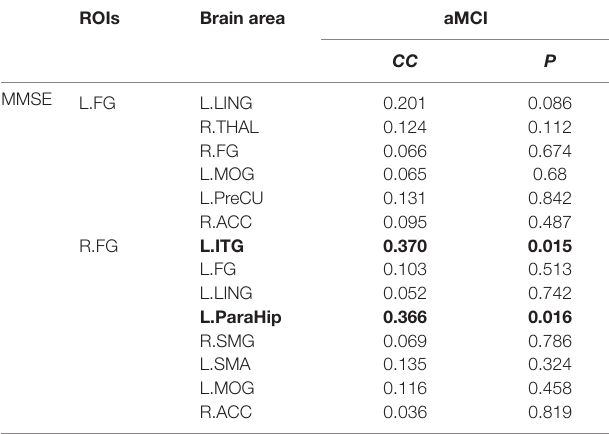
TaBle 4 | This table shows the correlation coefficient and corresponding P value between the functional connectivity values and MMse scores; the results for a threshold of P < 0.05 are shown in bold.